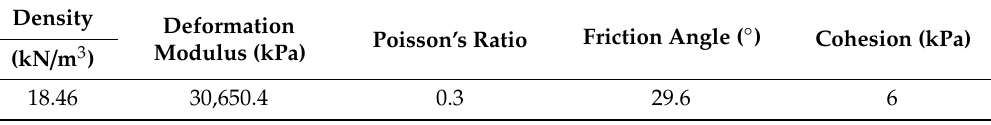
Table 4. Representative ground properties applied using the non-open-cut method.